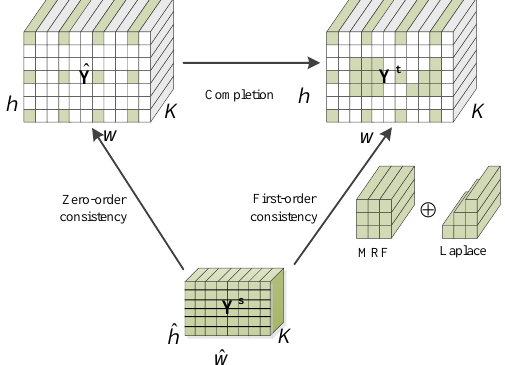
Figure 3. Structure label matrix completion